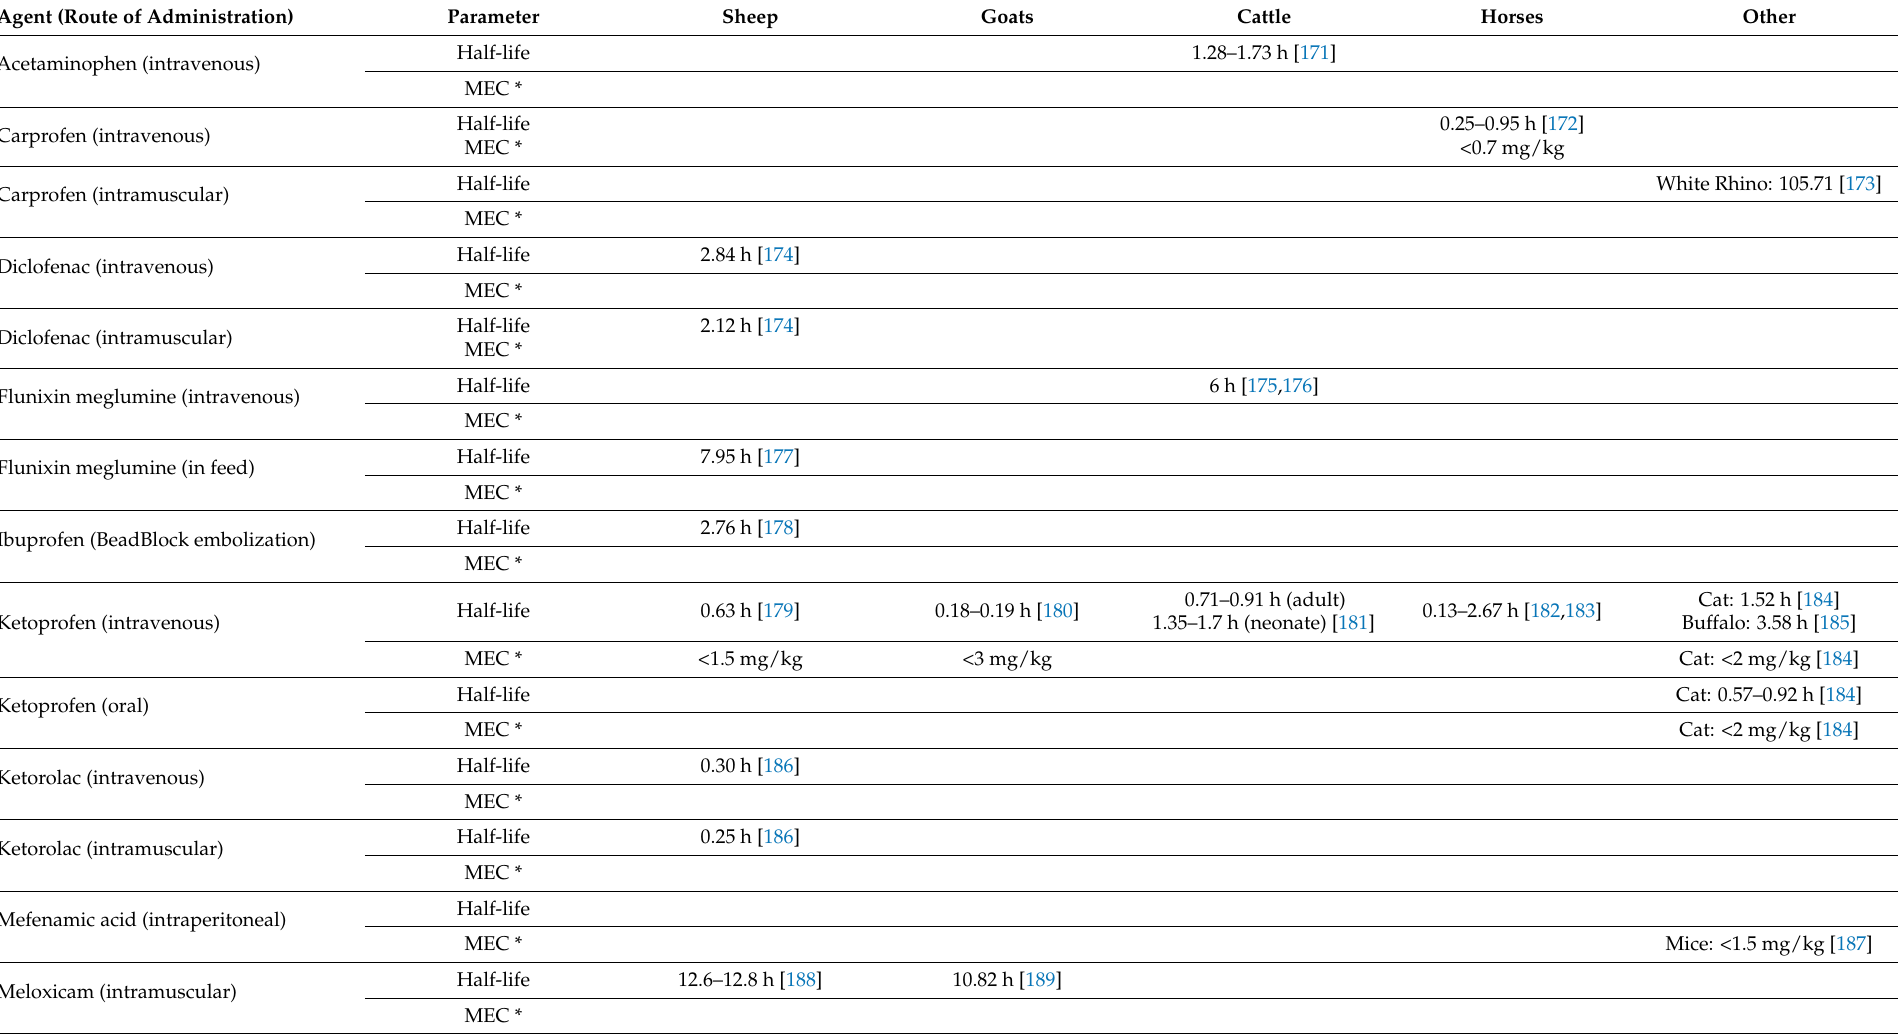
Table 4. Mean half-life of elimination and minimum effective concentration (MEC) in plasma of various NSAIDs in different species, reported in the period